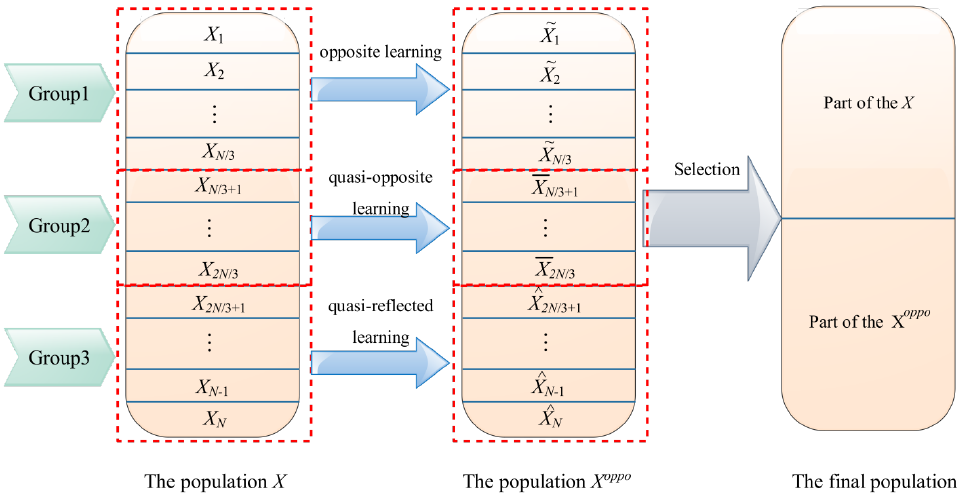
Figure 4. The process of opposite learning and